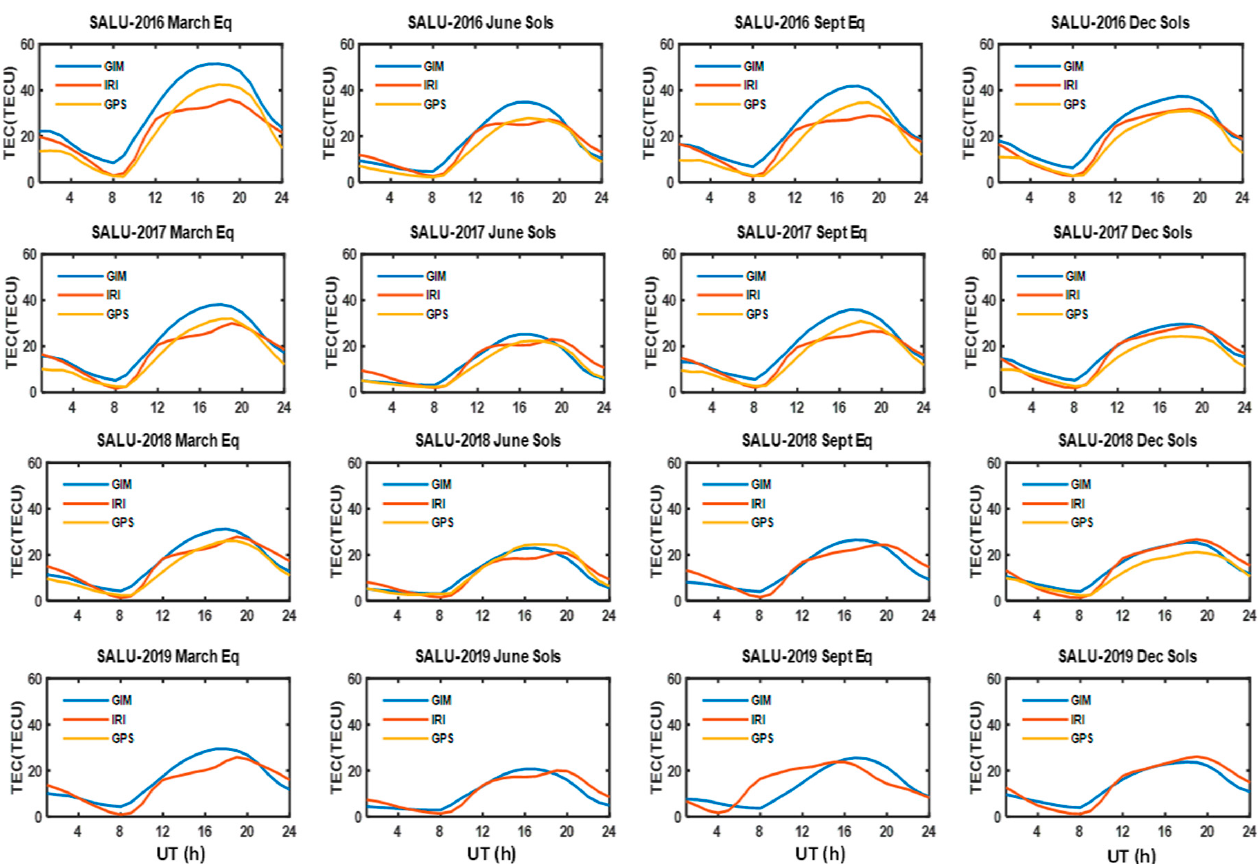
Figure 6. Seasonal variations in GPS-TEC, IRI-2016 and GIM models for descending (2016–2017) and minimum (2018–2019) phases of solar cycle 24 at SALU.